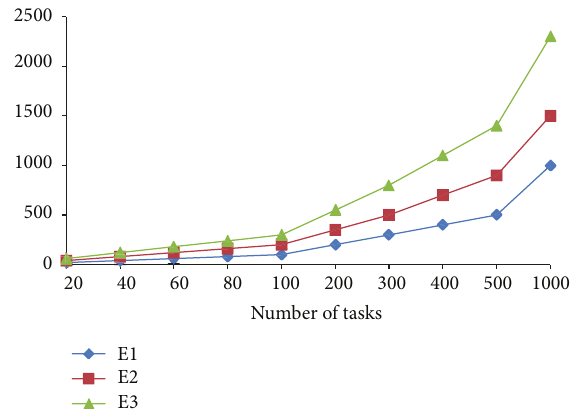
Figure 3: Results of the experiments with enough resources.